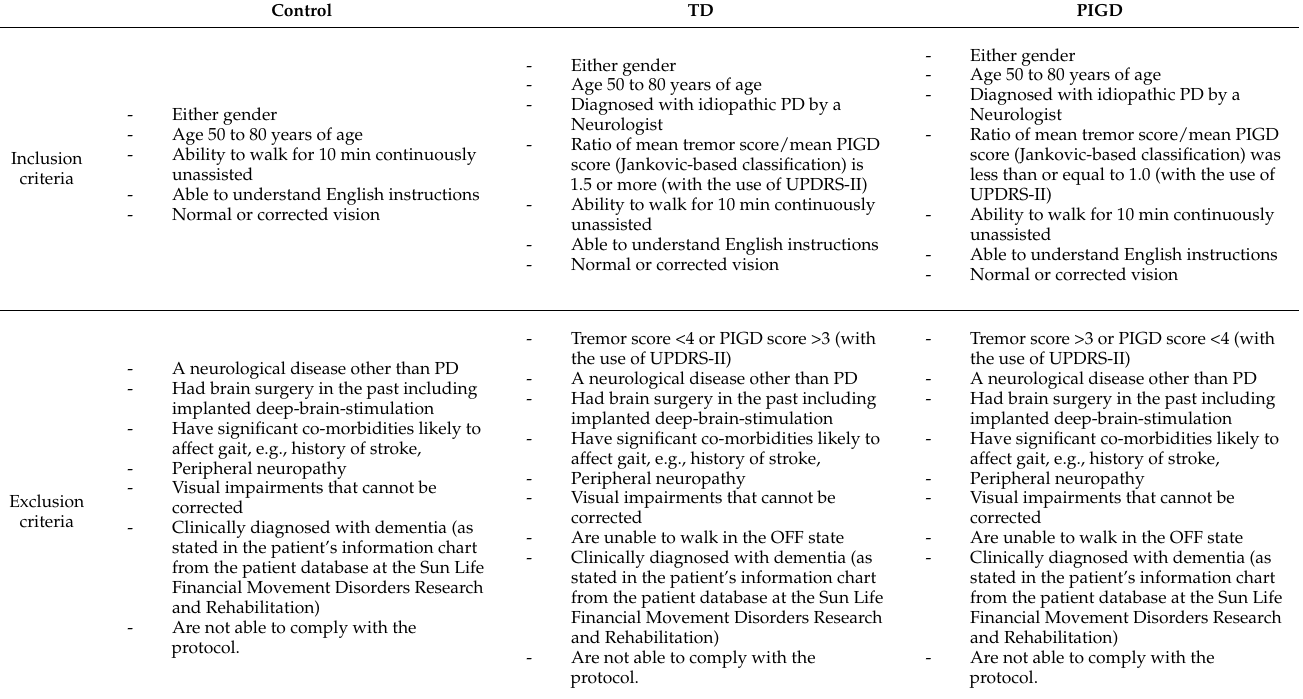
Table 1. Inclusion and exclusion criteria for the control group, PD patients with TD, and PD patients with